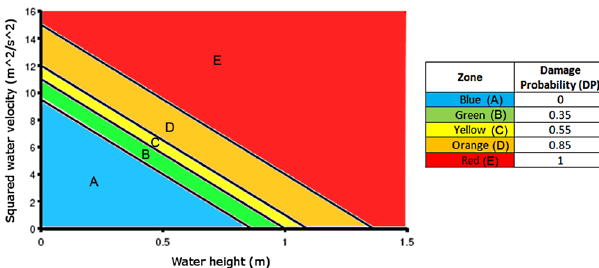
Fig. 6. Estimation of equipment damage probability with respect to maximum water height and